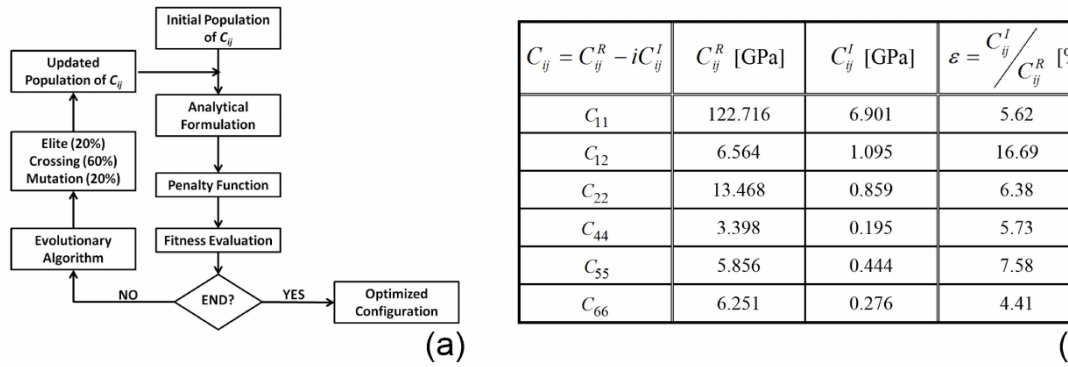
Figure 5. Schematic of inversion procedure to identify composite properties ( a ) and identified properties for [0 ˝ ] 8 C/E laminate ( b ) [13,19]. ( a ) reproduced from [19], Copyright Society for Experimental Mechanics,